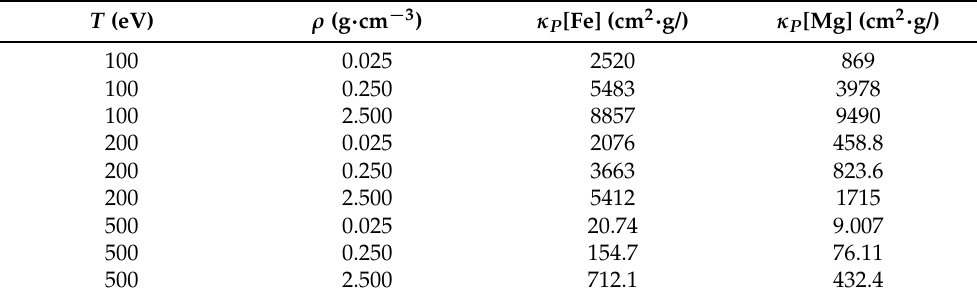
Table 5. Partial Planck mean opacities of iron and magnesium for a mixture plasma (number fractions of Fe and Mg are both equal to 0.5) at different temperatures (100, 200, and 500 eV) and densities (0.025, 0.25, and 2.5 g cm − 3 ). These partial densities are obtained by applying the same electronic · pressure to all ions in the plasma [33,34].